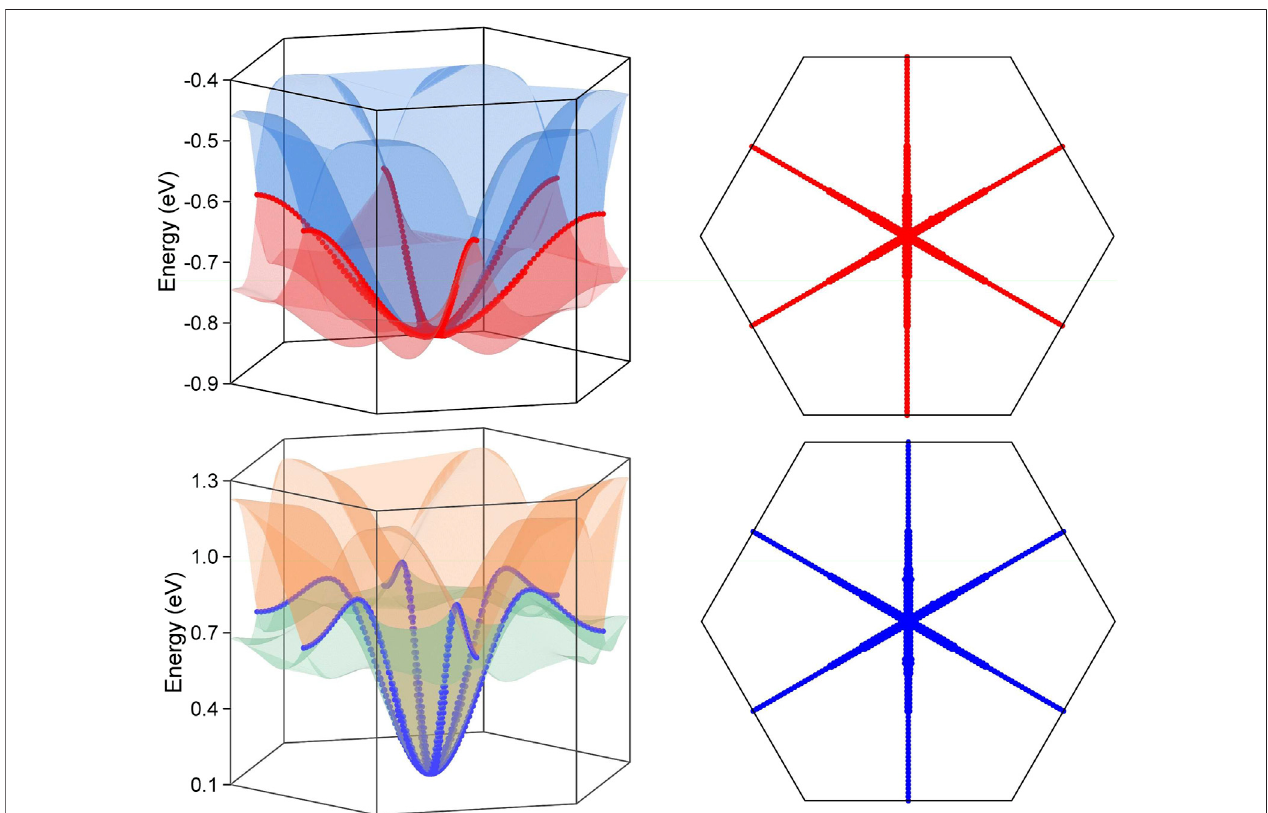
FIGURE5| Thethreedimensionalsurfacedispersionofthecrossingbandsalongthek z (cid:2) π planeforBaAgBiwithSOCeffectintheleftpanel.Thecrossinglinesare labelled by red and blue dots, which correspond to the two Dirac nodal lines. The exact spatial distribution of the two Dirac nodal rings along the k z (cid:2) π plane in the right panel.